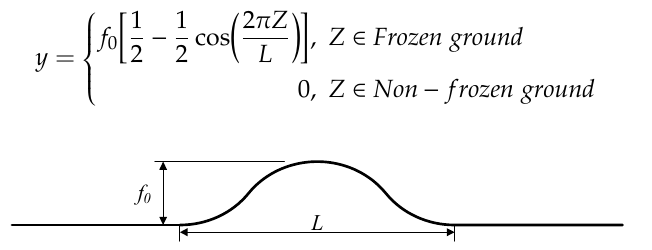
Figure 2. The frost heave simulated by an upper convex cosine